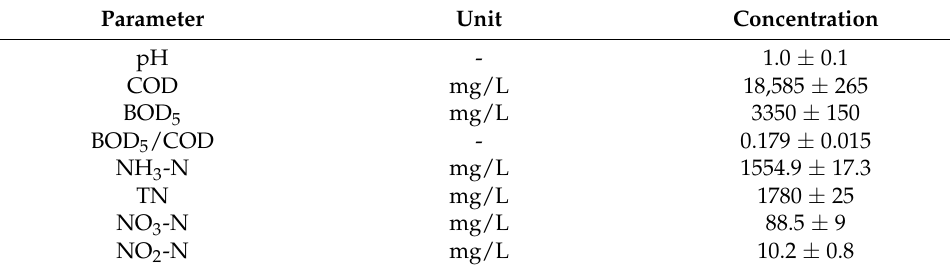
Table 1. Characteristics of the chemical pharmaceutical wastewater. Parameter Unit Concentration pH - 1.0 ±